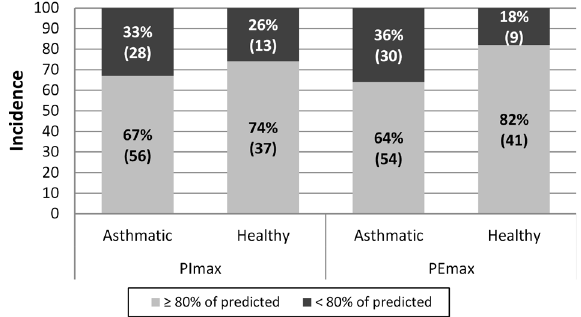
) Figure 2. Distribution of maximal inspiratory (PI max ) mouth pressures in and maximal expiratory (PE max boys with asthma compared to healthy boys.